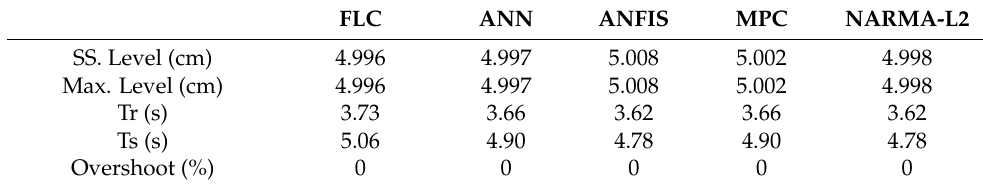
Table 6. Transient response for a reference value of 5 cm.